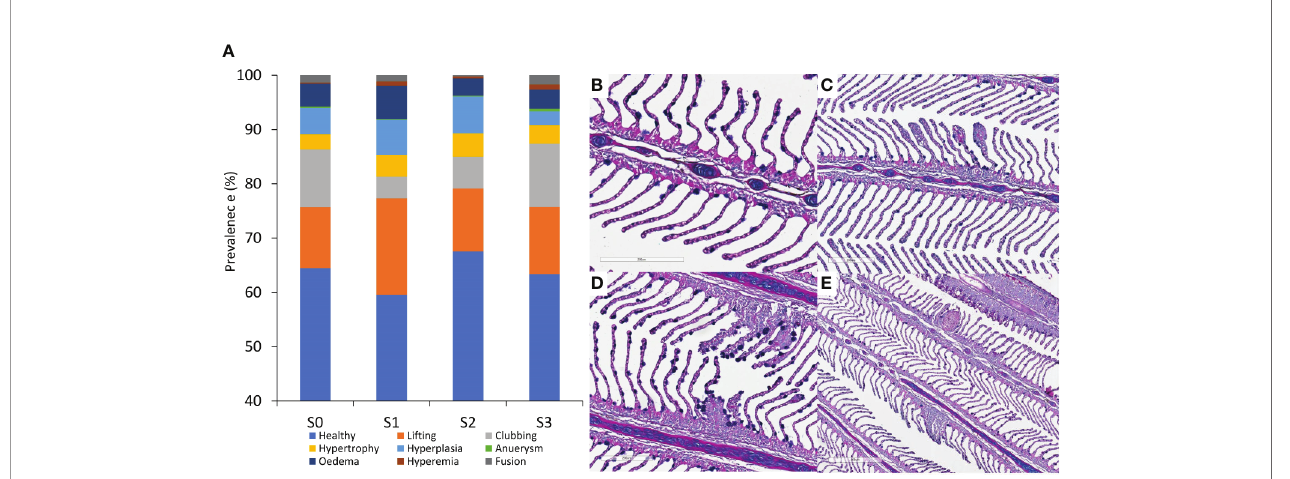
FIGURE 5 | Gill health status. (A) Quantitative histological evaluation was performed in a group of fi sh from the four sampling points, where common gill pathologies were accounted for and expressed in relation to the number of evaluated healthy lamella. Representative histological photos of (B) healthy gill fi laments with de fi ned structure and fair distribution of mucus cells, and some of the pathologies identi fi ed, including (C) clubbing, (D) hyperplasia at the base of the fi lament, with an increased number of mucus cells, and (E) aneurysm and advanced stage of hyperplasia. The data represent the evaluation from 15 individual fi sh (N=15) per sampling point.